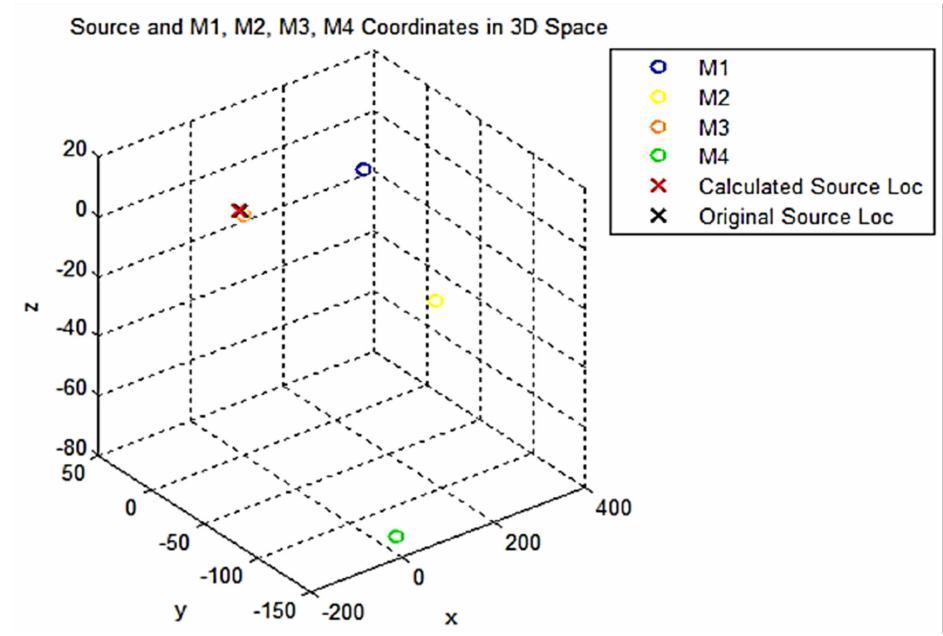
Figure 13. 3D model with source at ( − 2, 3, 1).